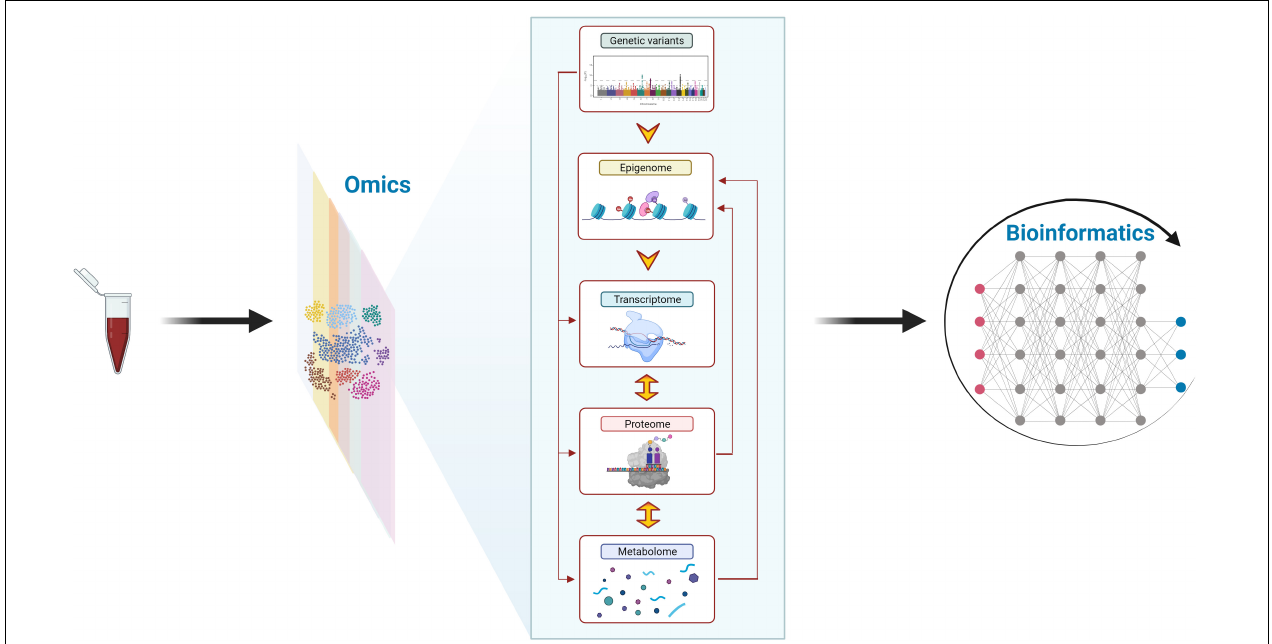
FIGURE 3 | The complex integration of “omics” data (i.e., multi-omics analysis) might contribute to a better understanding of the molecular mechanisms underlying the health-related benefits of physical activity in children and adolescents. The human genome is essentially invariant and comprises more than 25,000 genes, which encode ∼ 100,000–200,000 transcripts and 1 million proteins, and a smaller number of metabolites (2,500–3,000) make up the human metabolome (71). The epigenome, which can be influenced by physical activity in adults (15), shows a low/moderate temporal variance and influences both transcriptome and proteome. The transcriptome can be affected by a single bout of physical activity (36, 37) in children and presents a high temporal variance and is translated into the proteome, influencing the metabolome in a tissue-specific manner. Figure modified from Altmäe et al. (72) with permission of the Publisher. This figure was created with